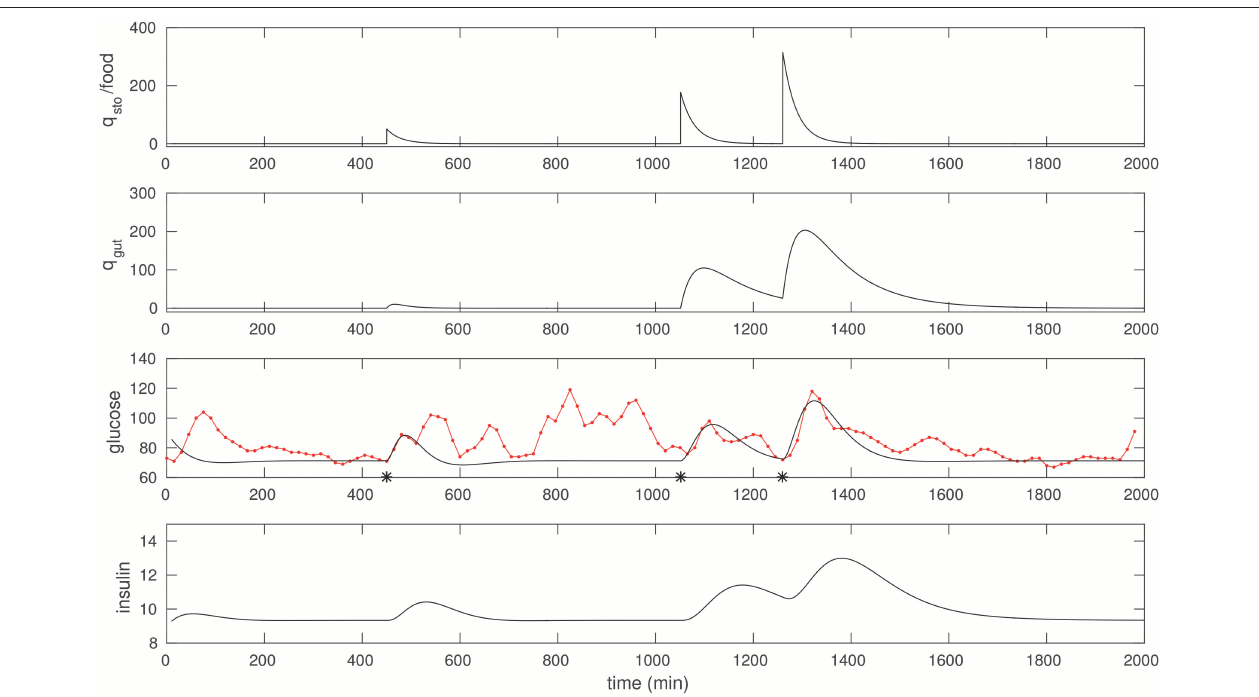
FIGURE 2 | The CGM of around 24 h of a non-diabetic subject, starting at midnight. The glucose data (red) is overlaid with the model simulation (black). Three foods were selected, and the times they were taken (450, 1,051, and 1,260 respectively) were recalled from the food diary; these are marked with asterisks. The first is a liquid meal at breakfast while the other two are mixed meals (the last one being dinner). These food pulses were fit; the fitted q sto amplitudes are 50, 177, and 316